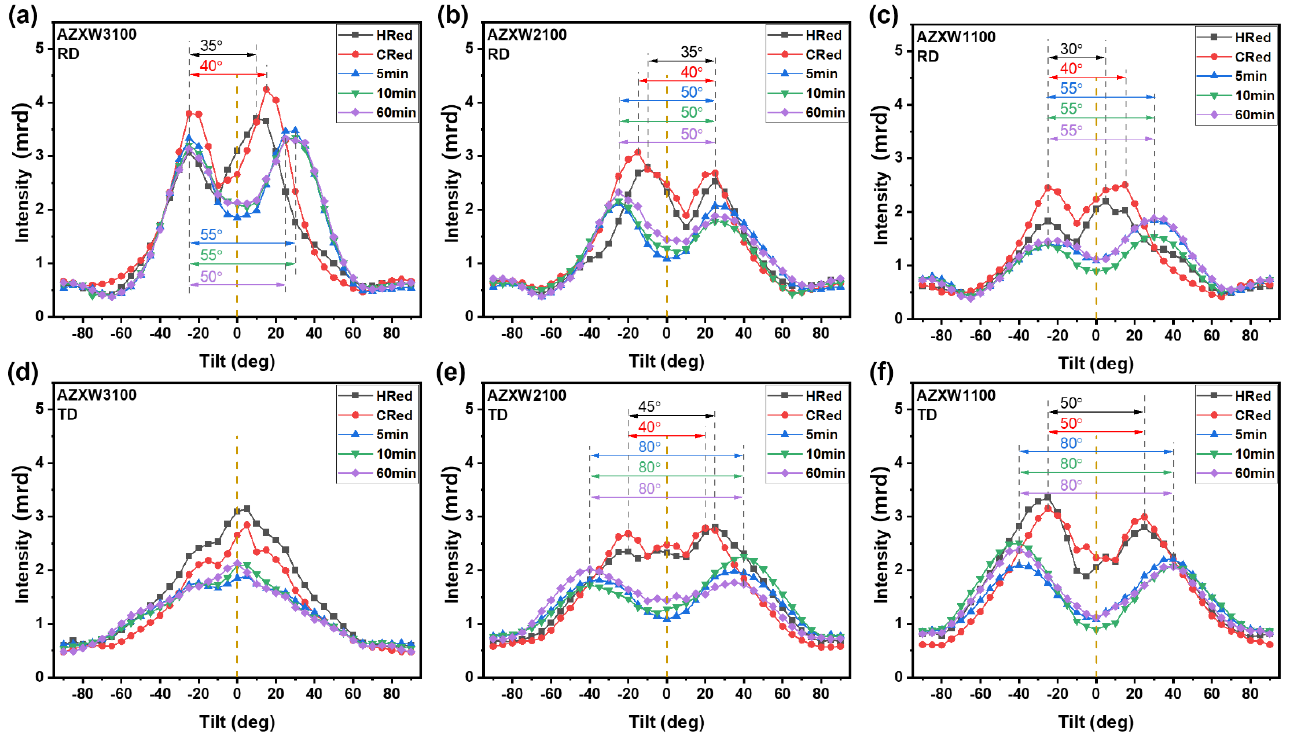
Figure 6. (0002) Pole intensities of the hot-rolled, cold-rolled, and annealed sheets from the ND along the RD ( a – c ) and TD ( d – f ) axes calculated from Figure 5: (a,d) AZXW3100, (b,e) AZXW2100, and (c,f) AZXW1100.